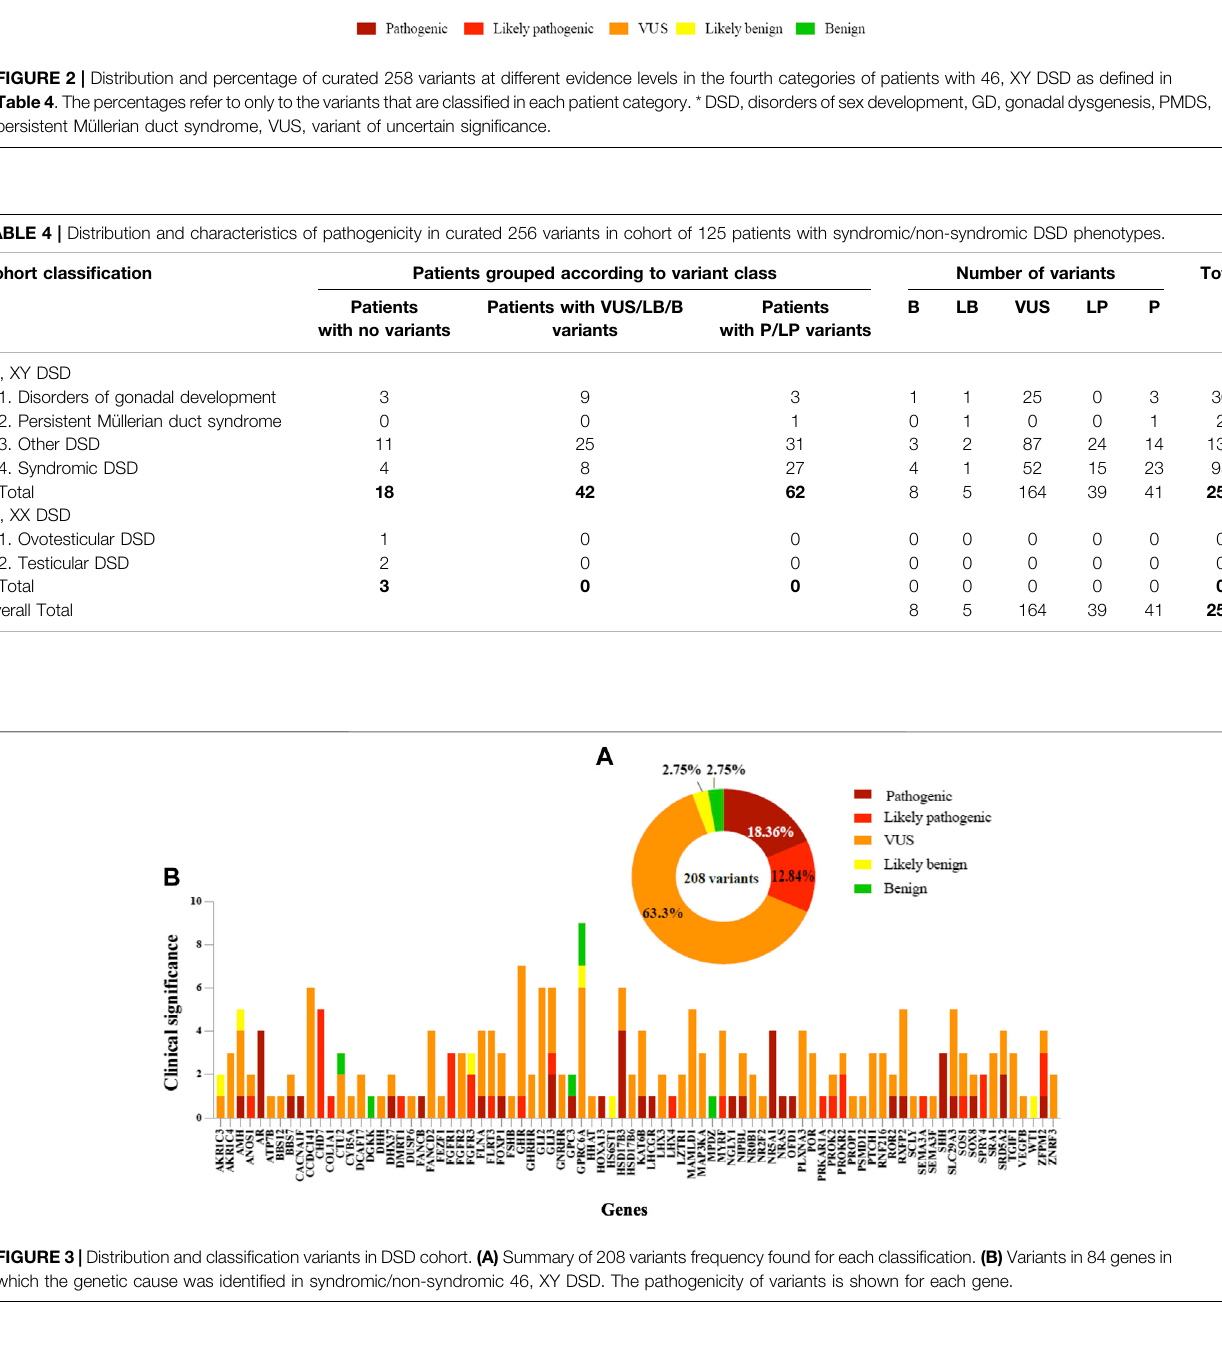
Frontiers in Genetics |